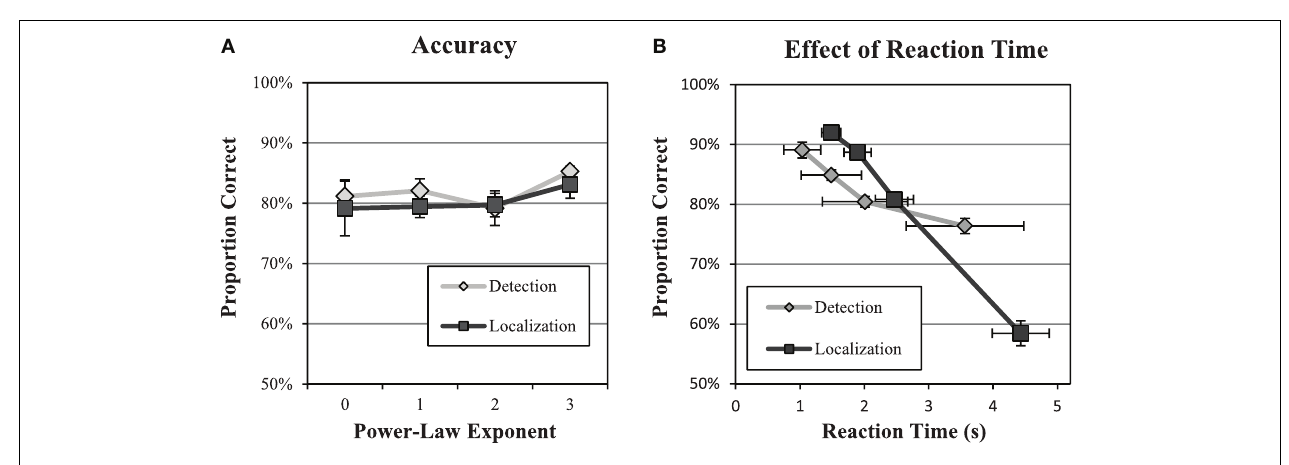
FIGURE 7 | Accuracy and reaction time. A check of performance levels in the efficiency data (A) shows that performance levels were reasonably close to the targeted 80% level. The midpoint